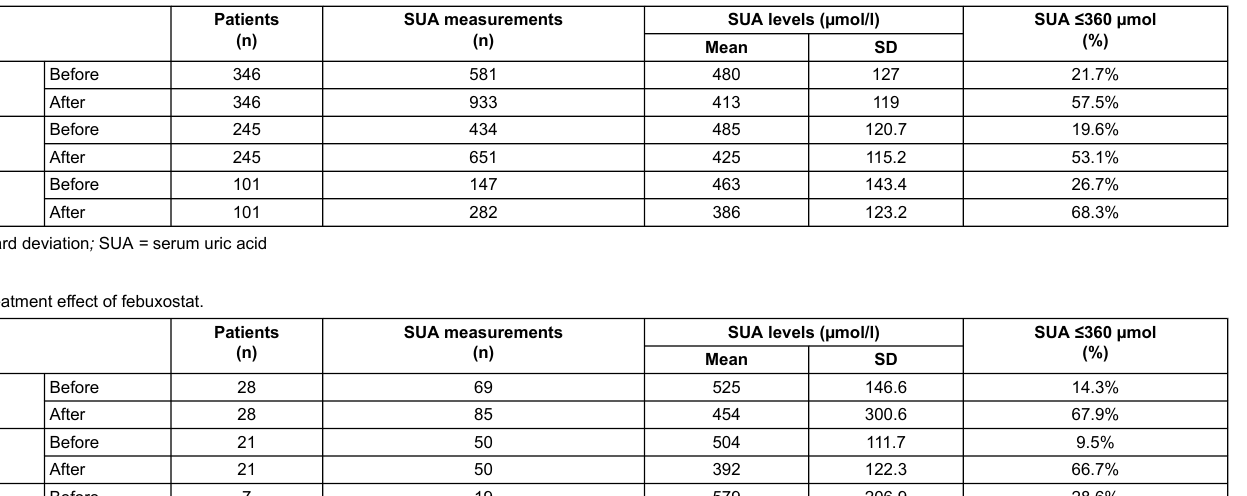
Table 2: Treatment effect of allopurinol.